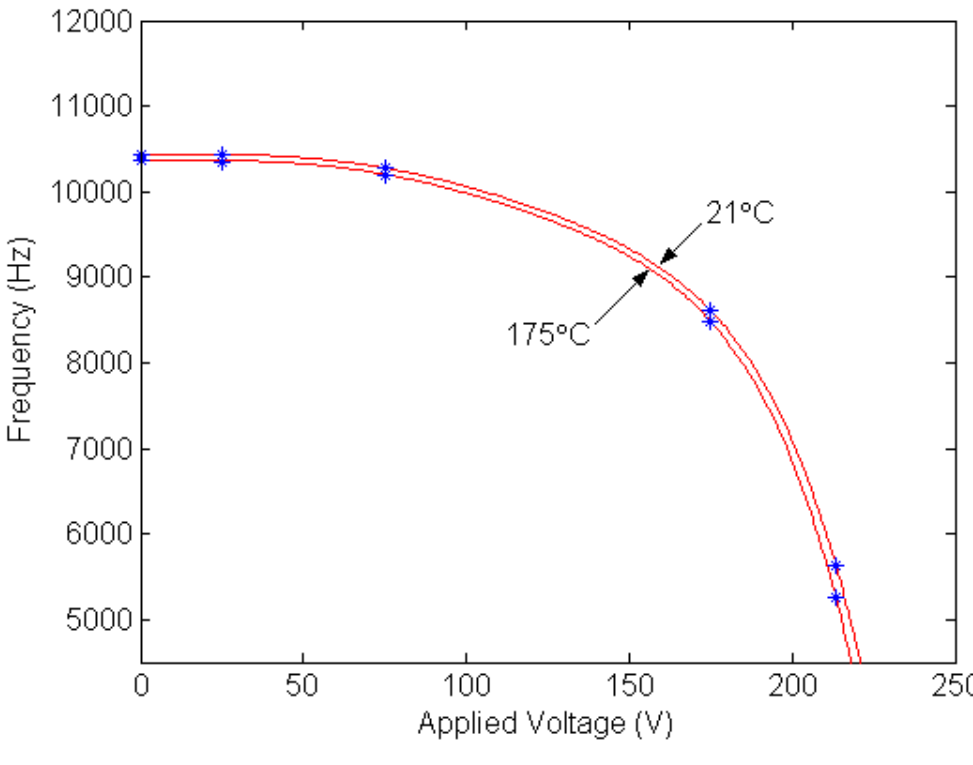
Figure 5. The resonant frequencies, at different temperatures, of the G1 AFM cantilever as a function of the applied DC voltage. The solid lines are the non- classical boundary support models. The standard deviations are 34.86 and 35.35 Hz for 21 ° C and 175 ° C,